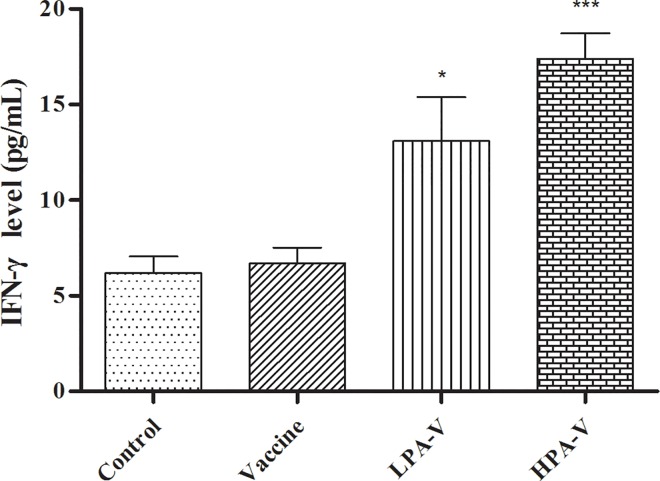
IFN-γ levels in the splenic lymphocyte supernatants induced by stimulation with three influenza virus antigens after 72 h in culture.After culture for 72 h with a final concentration of 40 μg/mL of HA or without ITIV antigens, the splenic lymphocyte supernatants were collected by centrifugation. According to the ELISA kit manufacturer's instructions, 50 μL of the cell supernatant was added to each well of the plate for IFN-γ cytokine analysis (n = 5). *P<0.05, ***P<0.001 vs. Control or Vaccine group.